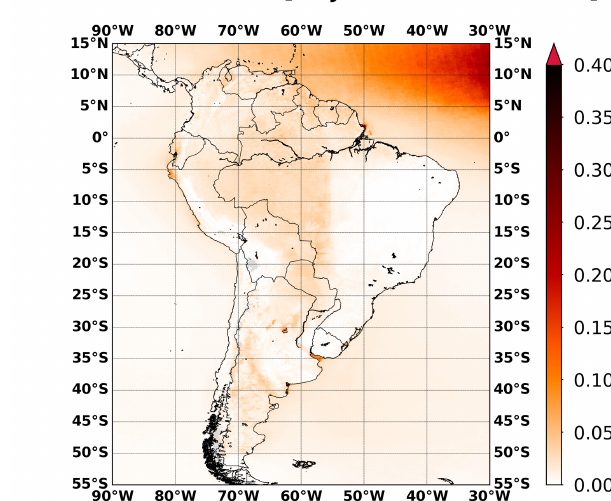
Figure 9. As in Fig. 1 but for South America.